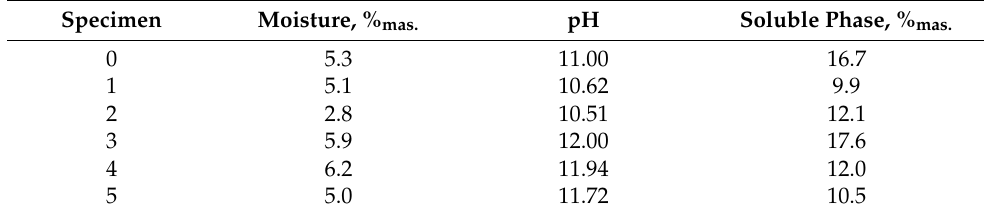
Table 5. A range of parameters for the concrete specimens. Specimen Moisture, % mas. pH Soluble Phase, %